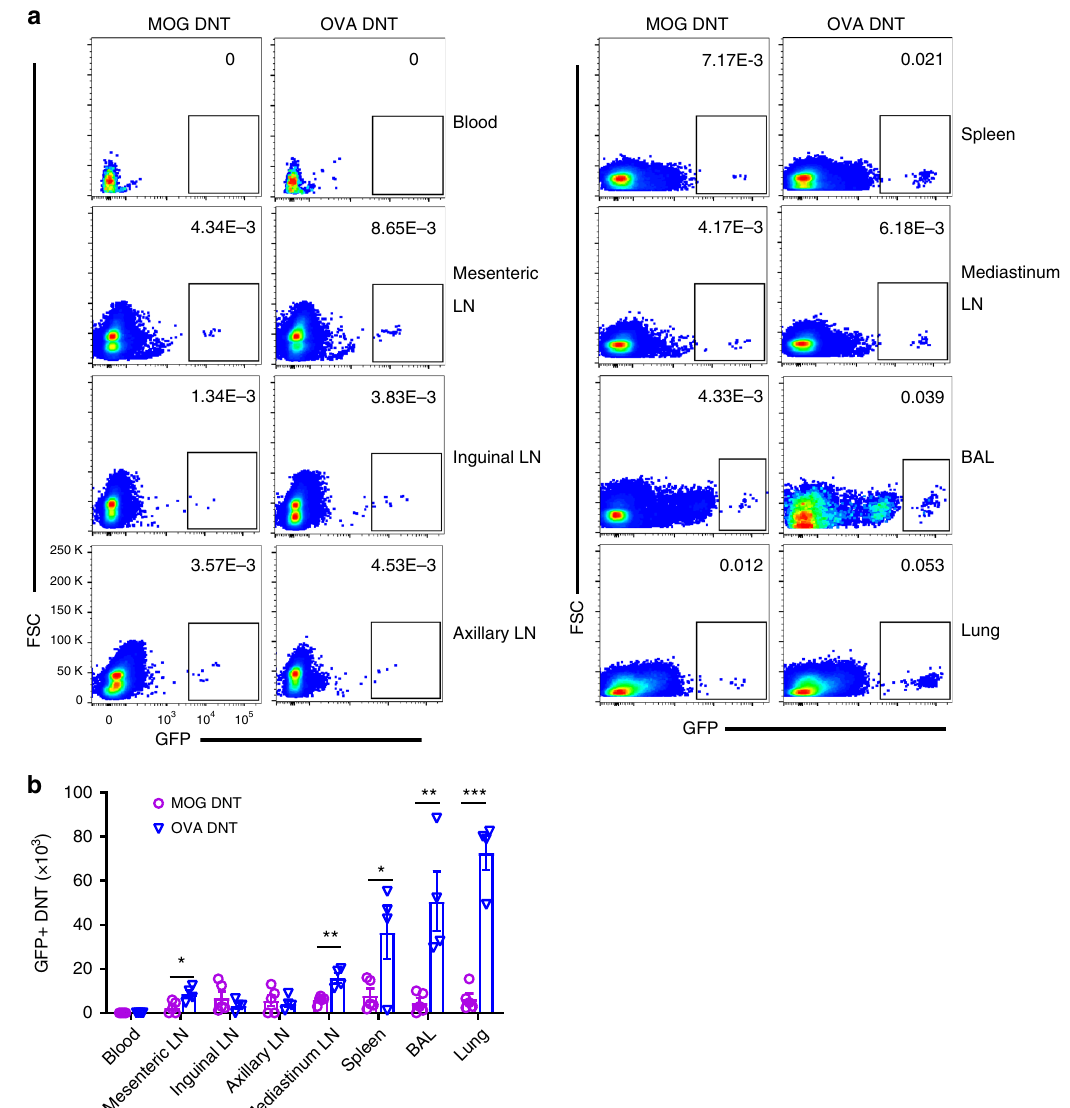
Fig. 2 OVA DNTs homed in to the lung to exert a protective effect. GFP + CD4 + T cells were converted to OVA or MOG DNTs via stimulation with the OVA 323 – 339 or MOG 35 – 55 peptide. GFP + DNTs were used to treat OVA-induced asthma. a The percentages and b numbers of GFP + cells in terms of the total cells in the lymphoid tissues were assessed by fl ow cytometry. Data are shown as the mean ± SEM; n = 4 mice per group. Student ’ s t- test was used to calculate signi fi cance. * P < 0.05; ** P < 0.01; *** P < 0.001. Source data are provided as a source data fi